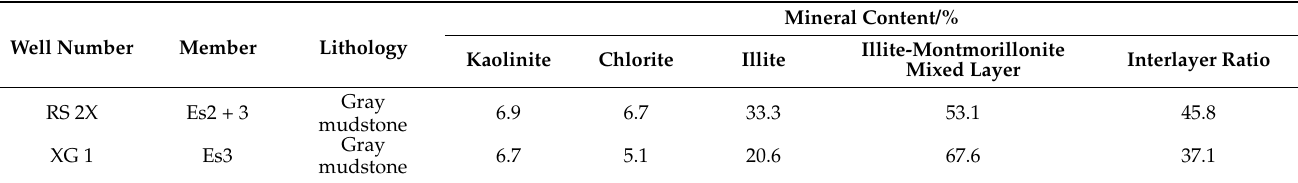
Table 9. Rock composition comparison of Es2 & Es3